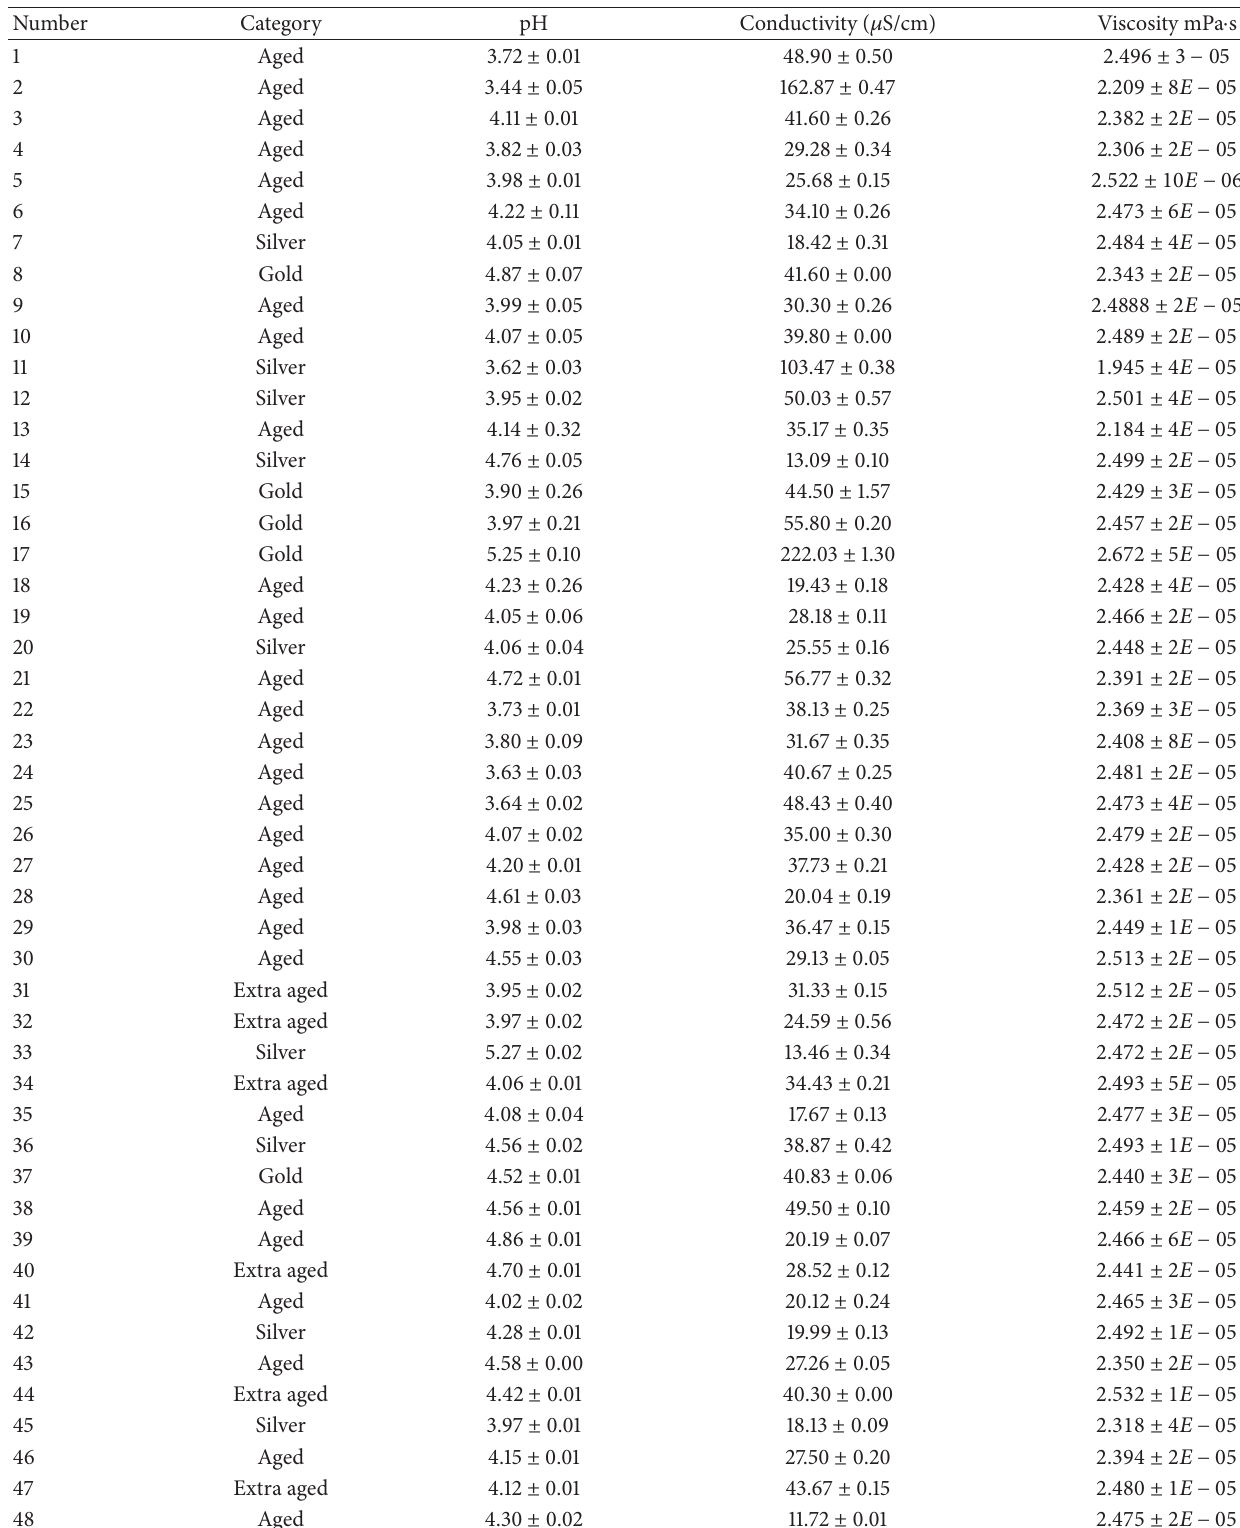
Table 1: Mean value and standard deviations for measurements of pH, conductivity, viscosity, density, sound velocity, and refractive index of 53 commercial tequila